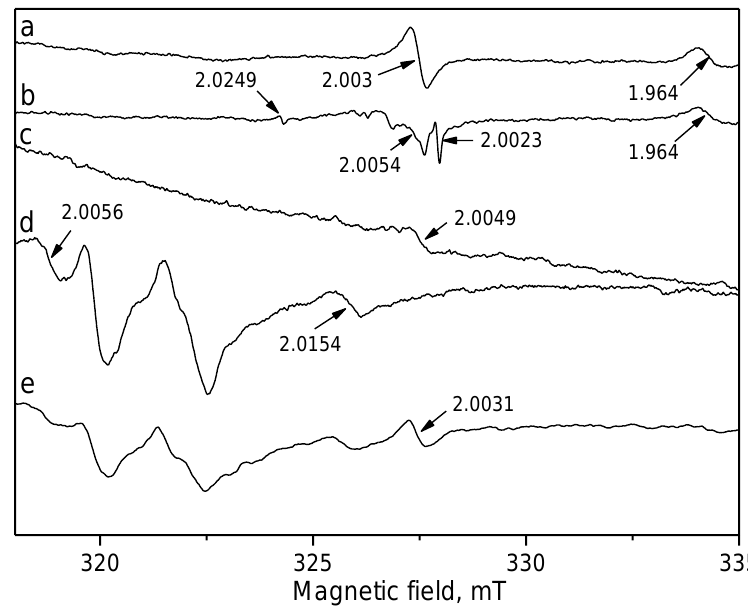
Figure 6. Electron paramagnetic resonance (EPR) spectra of samples after catalytic test: ( a ) Au/YCeAl; ( b ) Pd/YCeAl; ( c ) Pd-Au/YCeAl; ( d ) Au/Ce and ( e ) Pd/Ce.